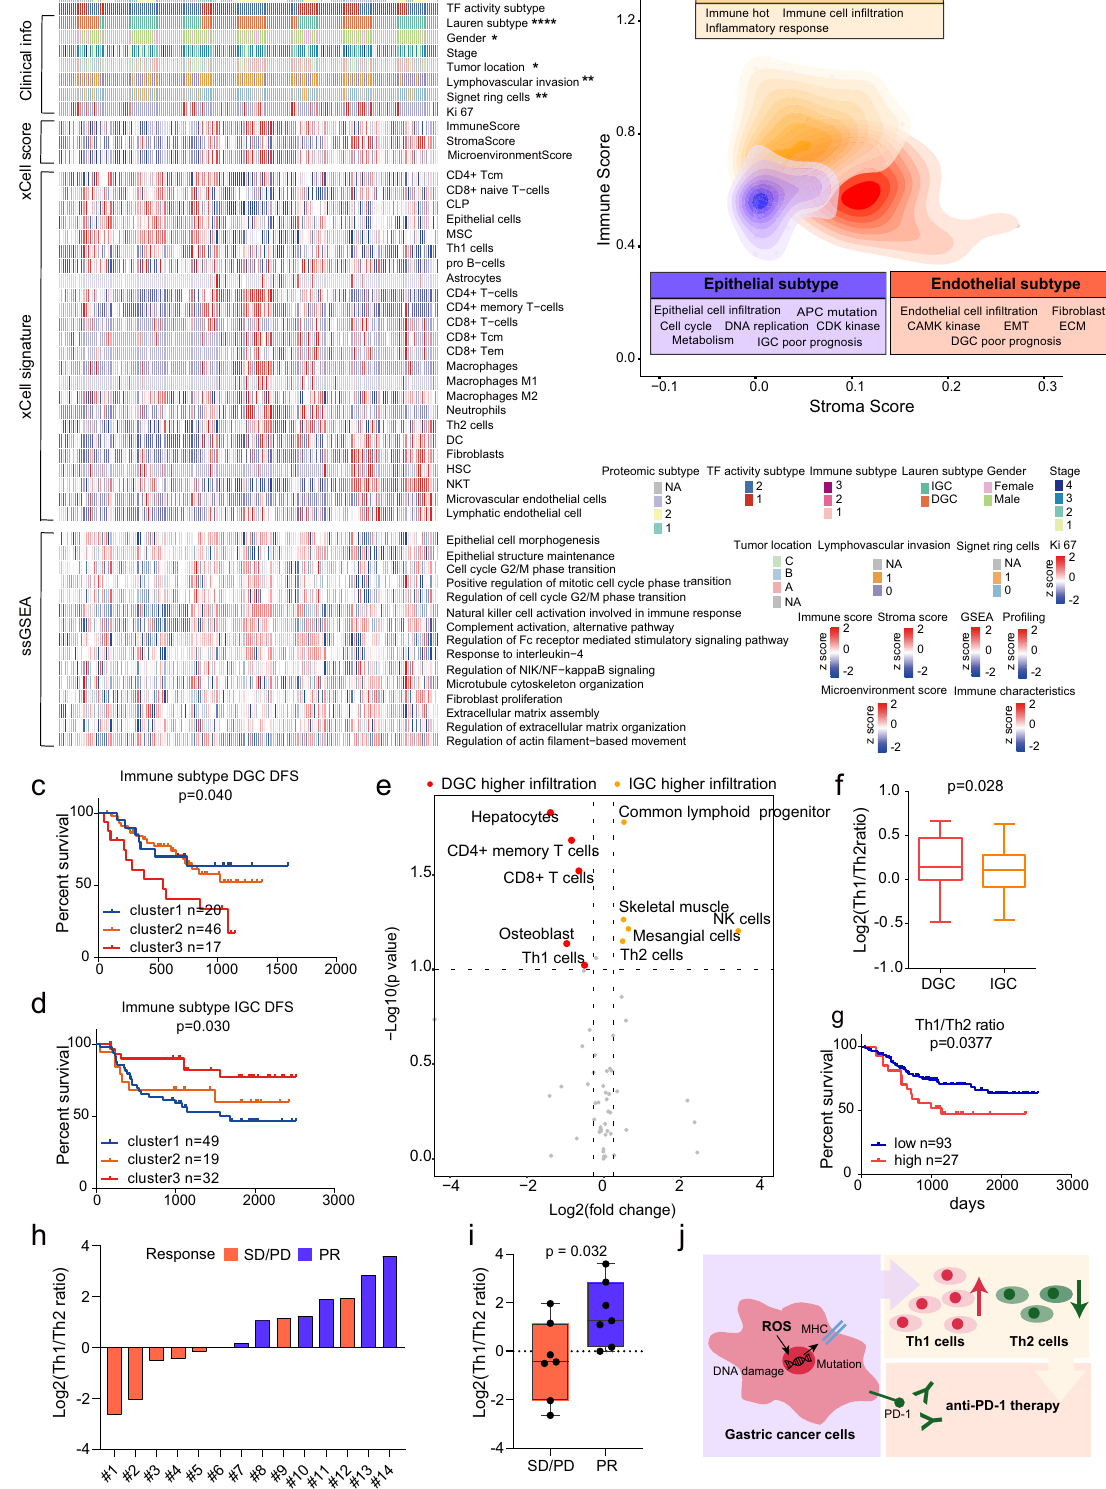
tumor in fi ltration of immune cells in DGC and IGC patients in immune cluster 3. The common lymphoid progenitor, NK cells, and Th2